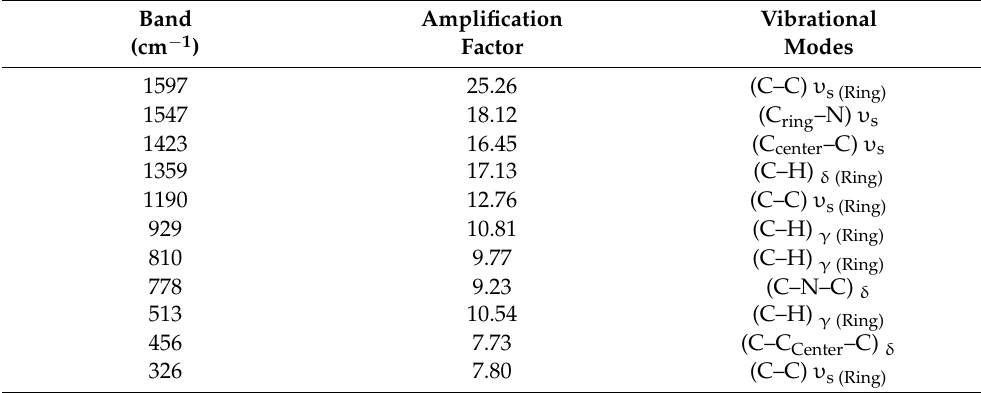
Table 6. Amplification factor for the bands observed in the Raman spectrum of the 1 mM violet crystal on the doped support for 5 min in a concentration of 5 mM AgNO 3